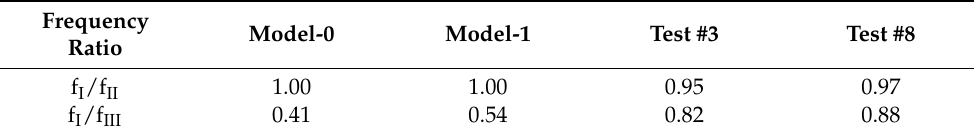
Table 3. The frequency ratio between the lowest resonant frequency and the others for Model-0, Model-1, and the experimental values in the two loading conditions: (i) absence of wind (Test #3) and (ii) with light wind (Test